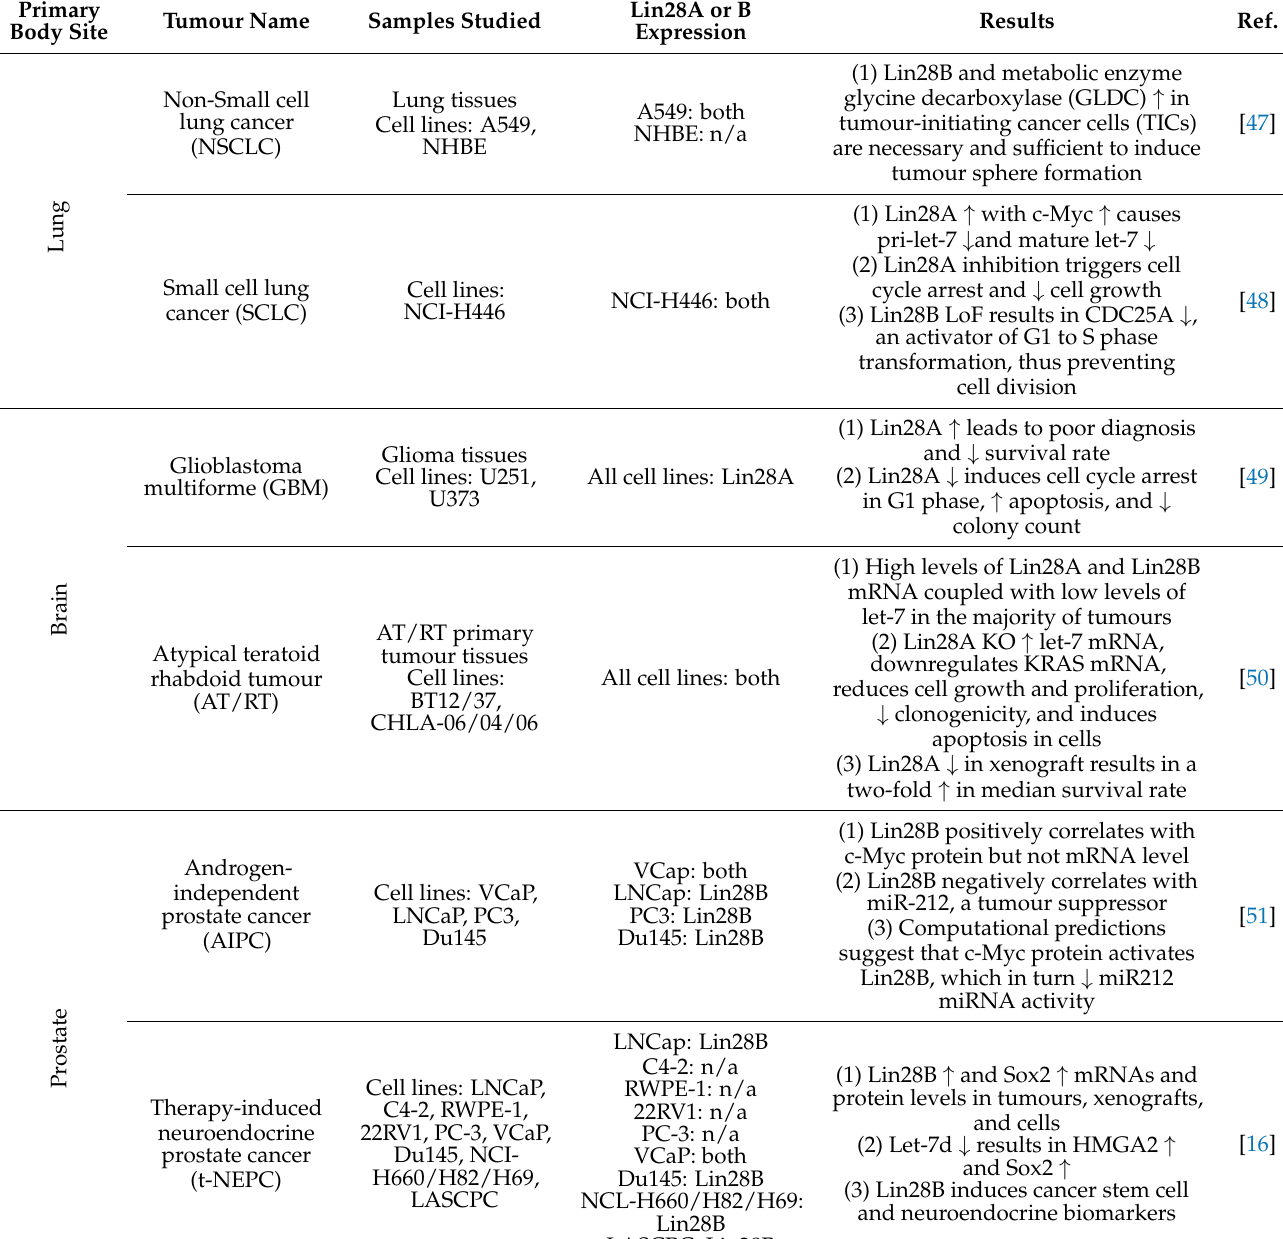
Table 1. Lin28 roles in cancers. Lin28A and B expression in human cancer cell lines were confirmed from the Cancer Cell Line Encyclopedia (CCLC) Dependency Map